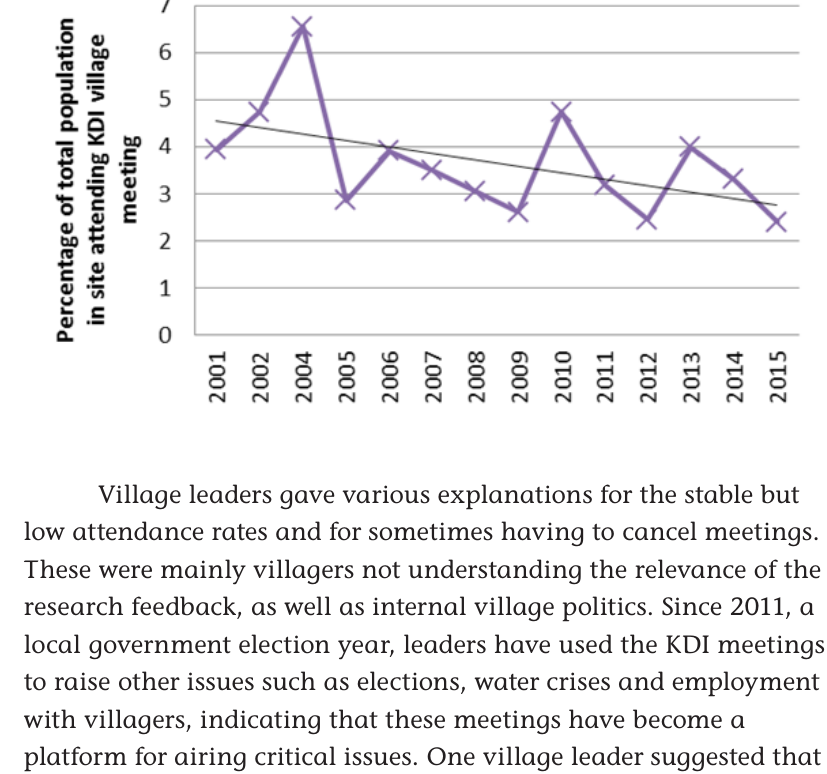
Figure 7: Percentage of